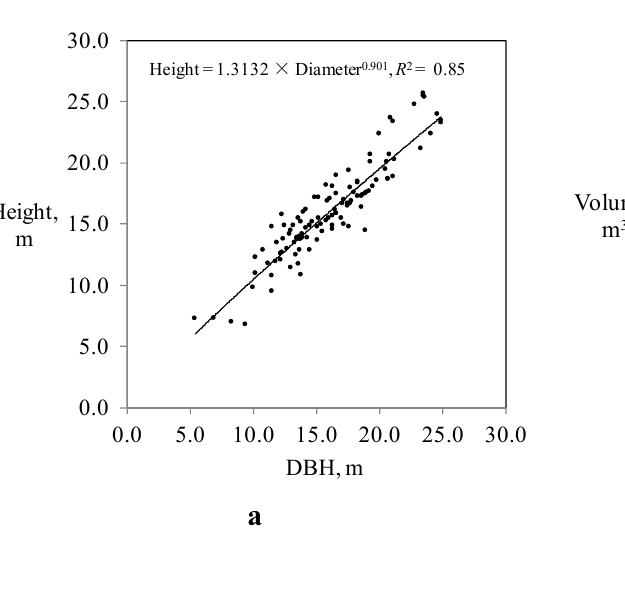
Figure 2. Relationship between diameter at breast height (DBH), cm and tree height, m, ( a ) and between DBH and stem volume, m 3 ( b